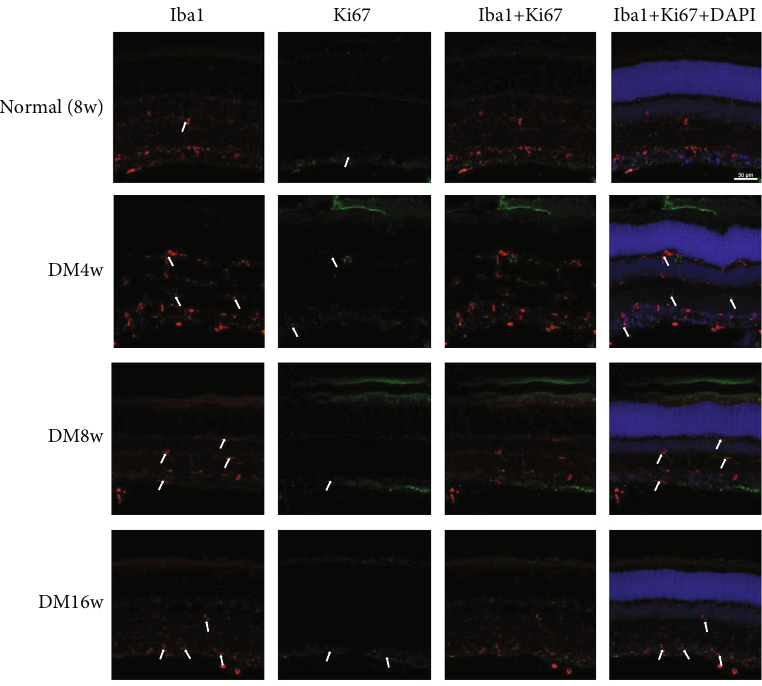
Figure 6: Changes in microglia in normal control and experimental diabetic rat retinas. The retina was immunostained with Iba-1 antibody (red) and Ki-67 (green). The nuclei were counterstained with DAPI